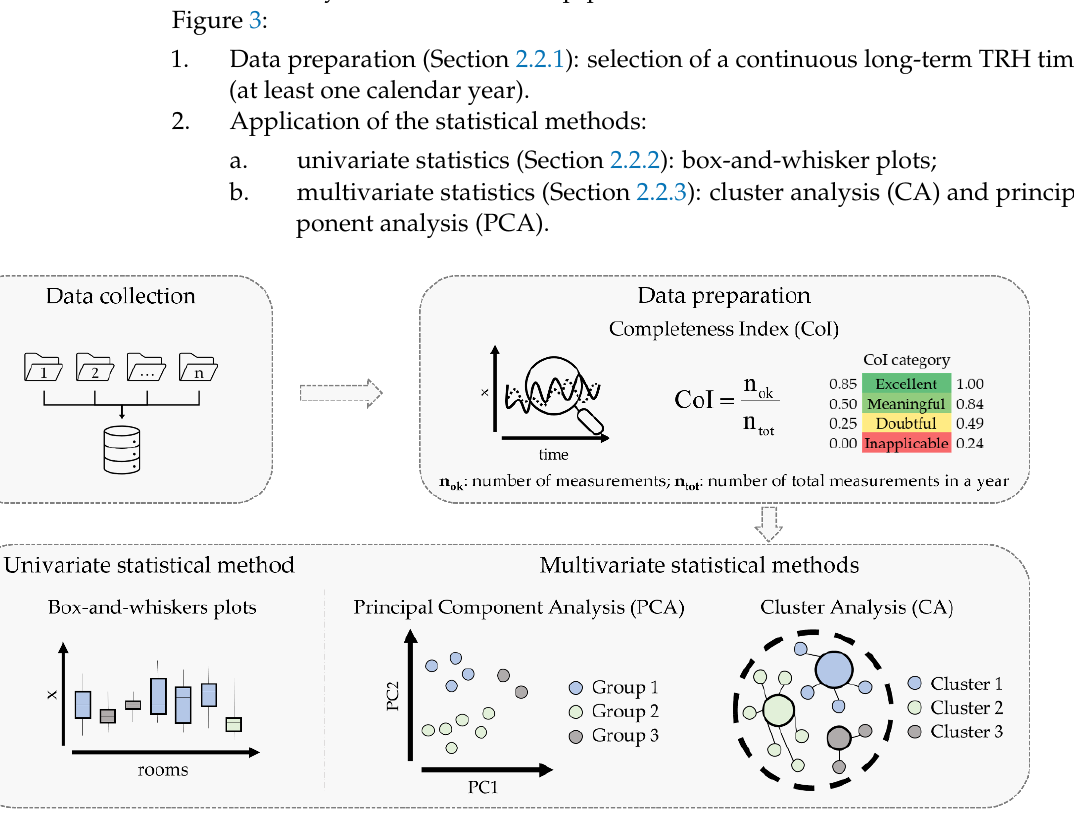
Figure 3. Schematic workflow of the approach: Data collection from several sensors located in different rooms; data pre-processing to select long-term time series in multi-room observations; application of statistical methods to identify microclimate similarities among rooms to be associated with climate-room blocks.